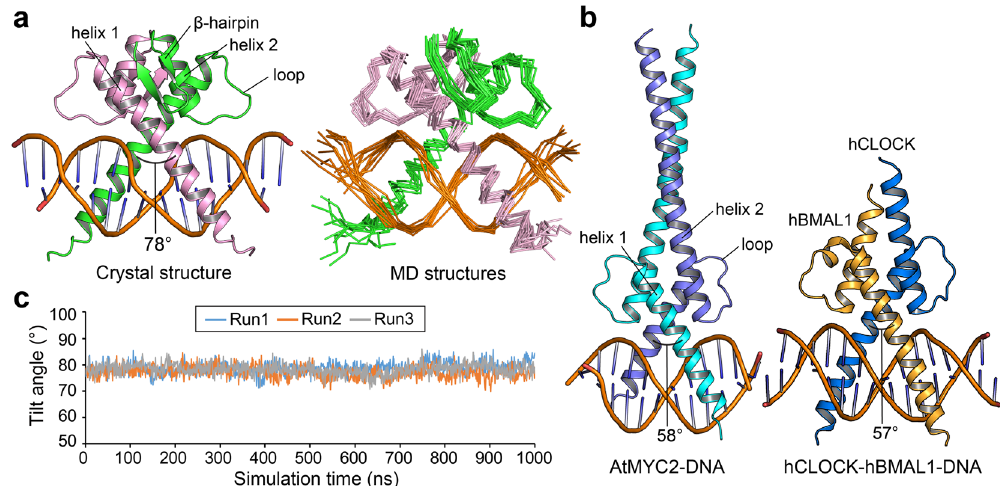
Figure 4. MD simulations for the AtBIL1/BZR1-DNA complex. ( a ) The crystal structure and MD structures (every 100 ns (ns) up to 1000 ns) of the AtBIL1/BZR1-DNA complex (PDB ID: 5ZD4, chains C, D, G and H, assembly 2). The tilt angle between the DNA recognition helices is shown on each crystal structure. ( b ) Crystal structures of the AtMYC2-DNA complex (PDB ID: 5GNJ, chains A–D) and hBAL1-hCLOCK-DNA complex (PDB ID: 4H10, chains A–D). ( c ) Tilt angles between DNA recognition helices of AtBIL1/BZR-DNA every 1 ns up to 1000 ns (three independent runs). The MD structures ( a ) correspond to the results of Run